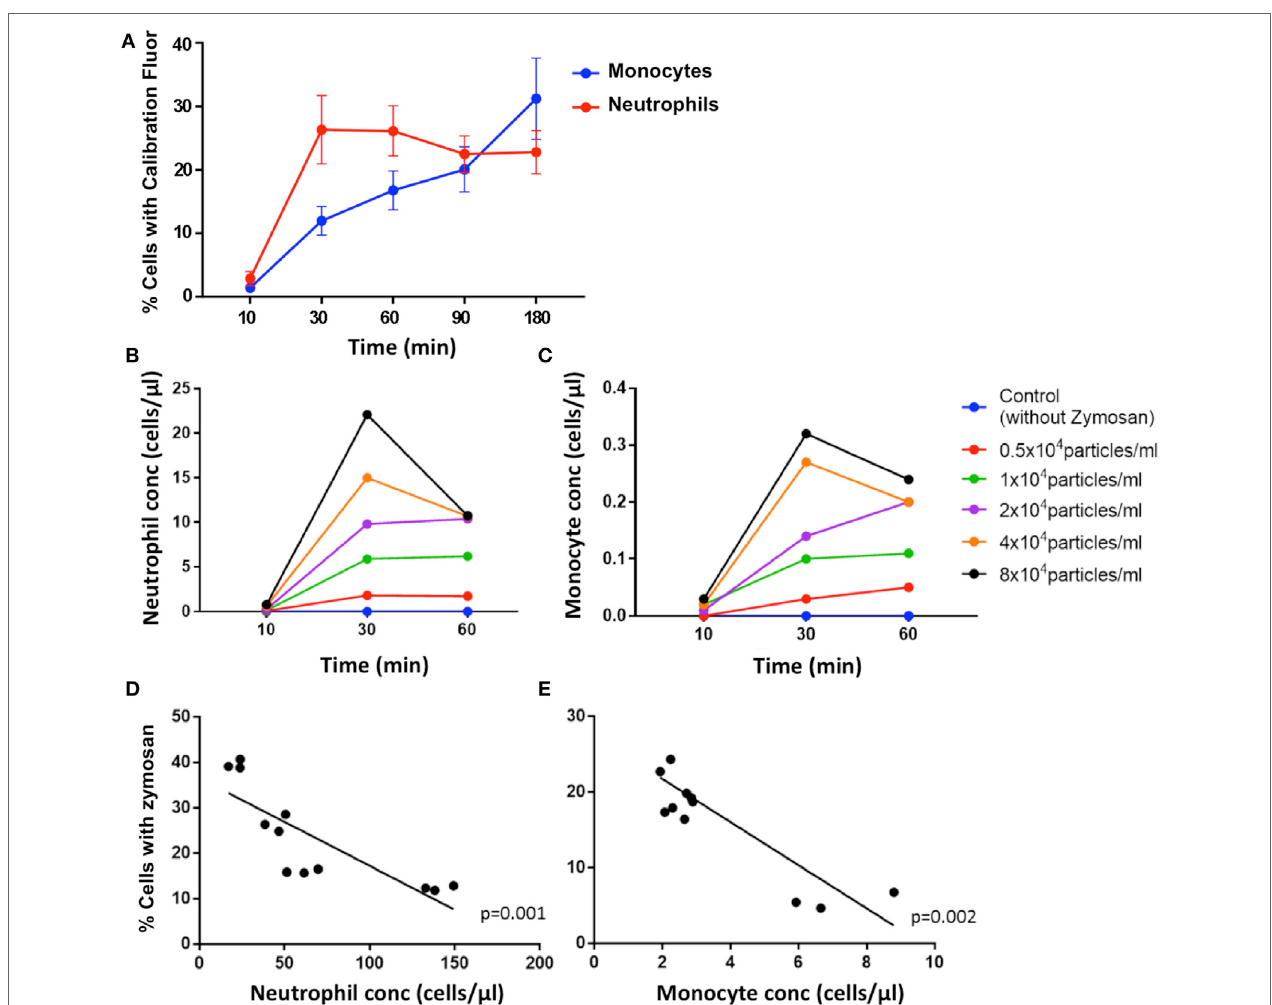
FIGURe 2 | Phagocytosis of zymosan reporter particles by monocytes and neutrophils. (A) Proportion of cells that have phagocytosed zymosan over time using blood from healthy individuals incubated with approximately 2 × 10 4 zymosan particles/ml. Data represent mean values, and the error bars indicate SEM. Concentration of neutrophils (B) and monocytes (C) that have internalized zymosan reporter particles over time, with varying concentrations of particles. Relationship between the proportion of cells internalizing zymosan reporter particles (at an approximate concentration of 2 × 10 4 zymosan particles/ml) and absolute cell concentration for neutrophils (d) and monocytes (e) after 60 min. Each data point represents one sample from each individual done in triplicate. Four healthy volunteers in triplicate are shown in panels (A,d,e) , and one health volunteer is shown in panels (B,C)